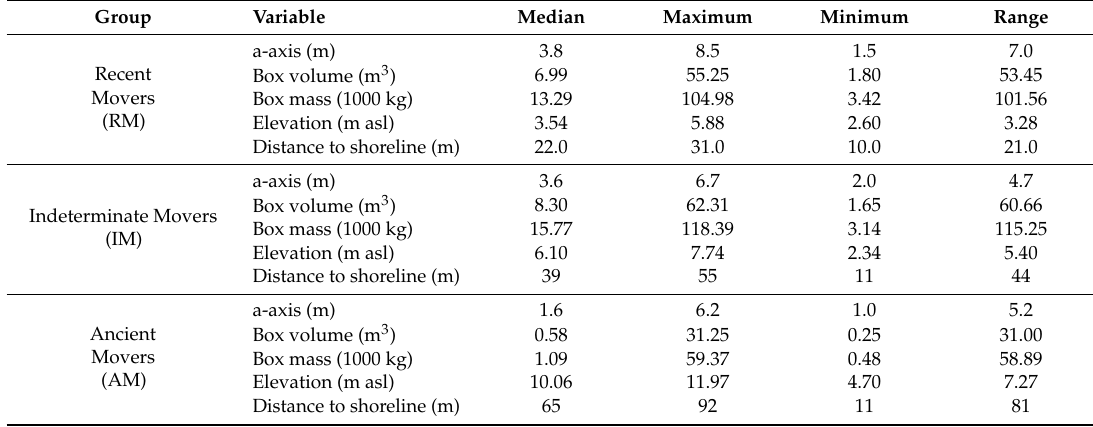
Table A1. Characteristics of boulders of